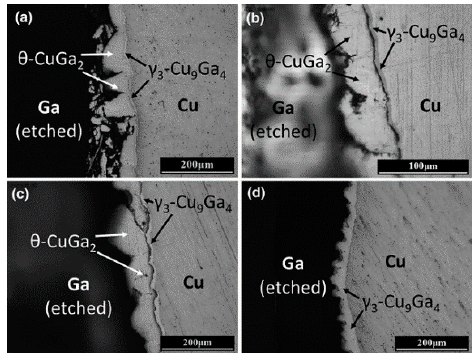
Figure 7. Ga/Cu couples reacted at 200 °C for ( a ) 3 h, ( b ) 6 h, ( c ) 24 h, and ( d ) 48 h [60].